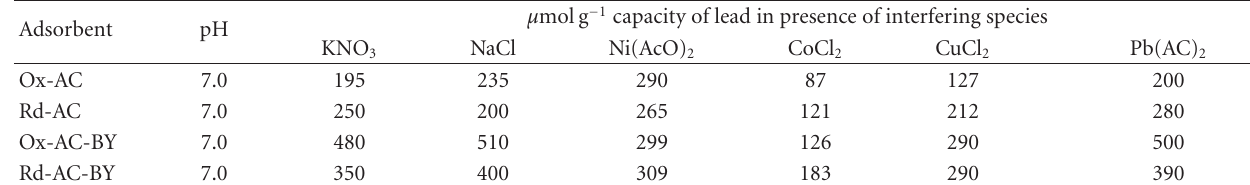
Table 5: E ff ect of foreign ions on the metal capacity values of lead.